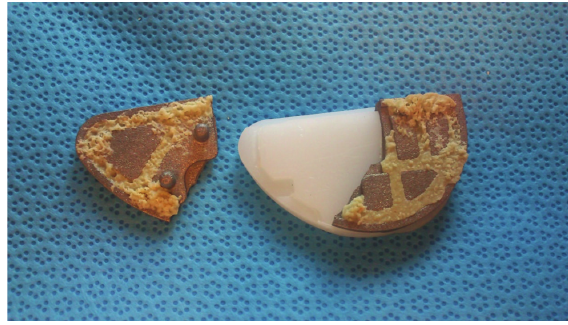
Figure 4: The fractured tibial baseplate.